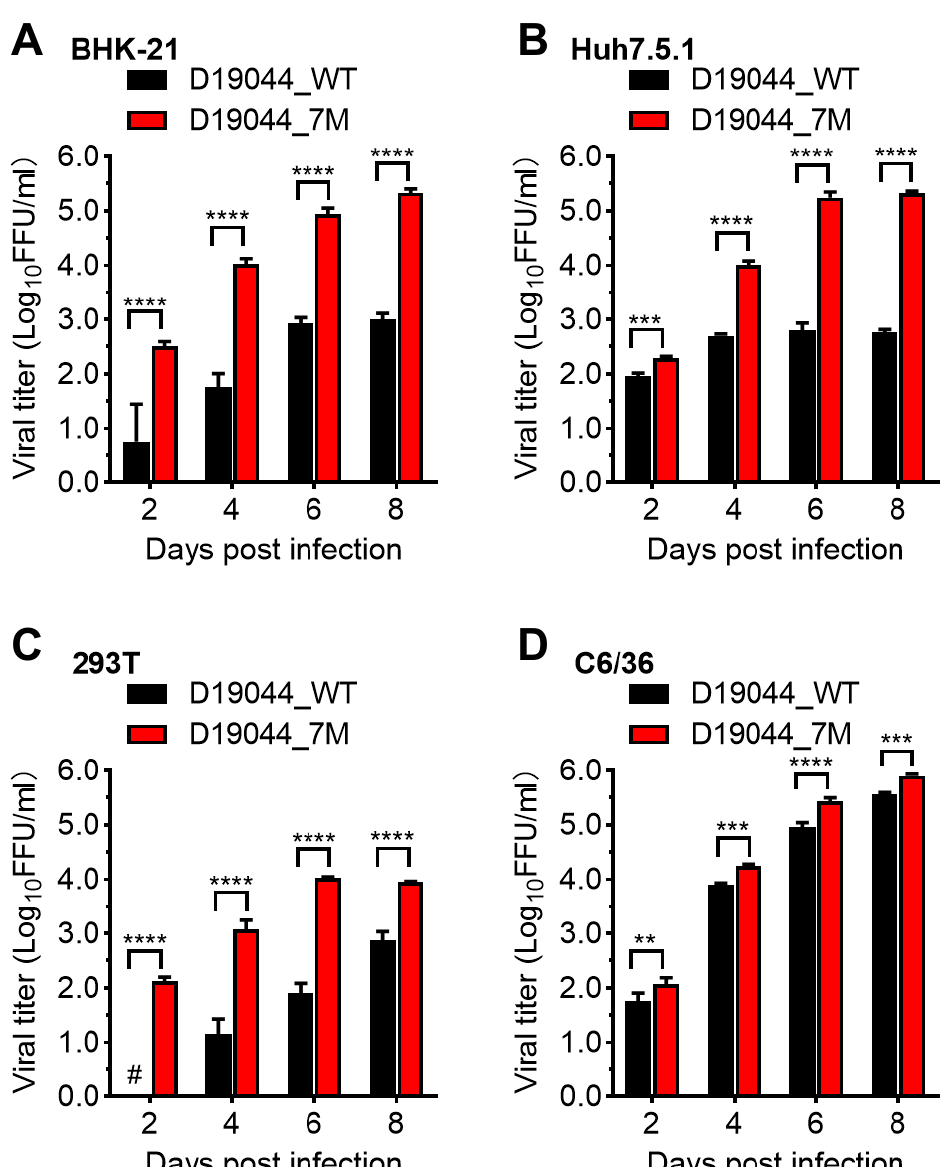
Figure 5. Virus production of D19044_WT and D19044_7M in various cell lines. BHK-21 cells ( A ), Huh7.5.1 cells ( B ), 293T cells ( C ), and C6/36 cells ( D ) were infected with D19044_WT and D19044_7M (MOI = 0.001). The viral titers released in supernatant were determined by FFU assay. A “#” indicates the titer was below LOD (<0.69 log 10 FFU/mL). The means ± SEM of three independent experiments are shown. Statistics analysis were performed using multiple comparison test in a two-way